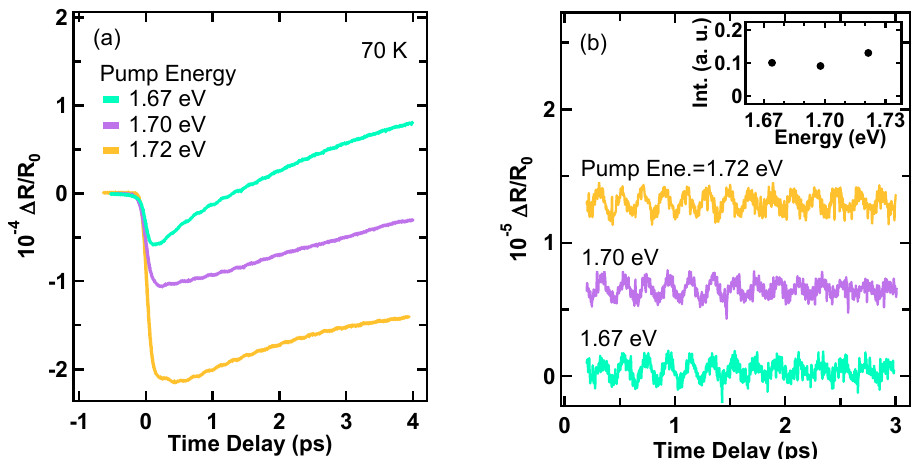
Figure 10. ( a ) ∆ R / R 0 signals in the YMnO 3 thin film at different pump photon energies at the pump power of 20 mW at 70 K. ( b ) Time-domain oscillatory signals obtained from ( a ). The inset indicates the integrated intensities of the FT bands of the oscillatory signals.